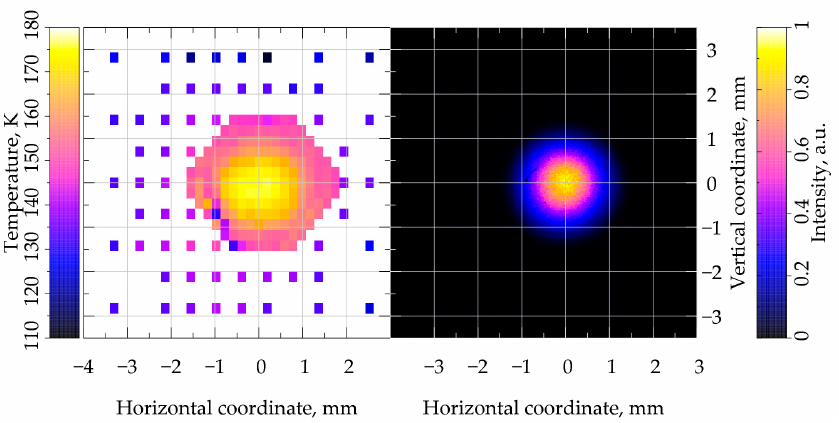
Figure 4. Two-dimensional distribution of equivalent temperature ( left ) and radiation intensity of the pump ( right ).